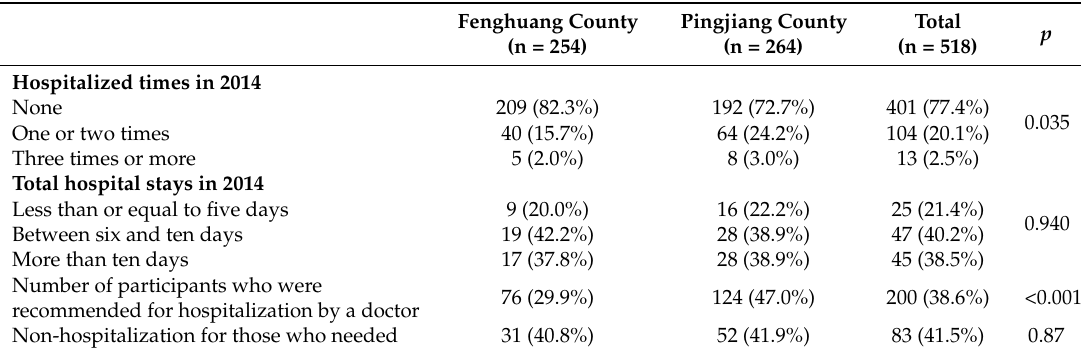
Table 4. Hospitalization among CLBC (n, %).